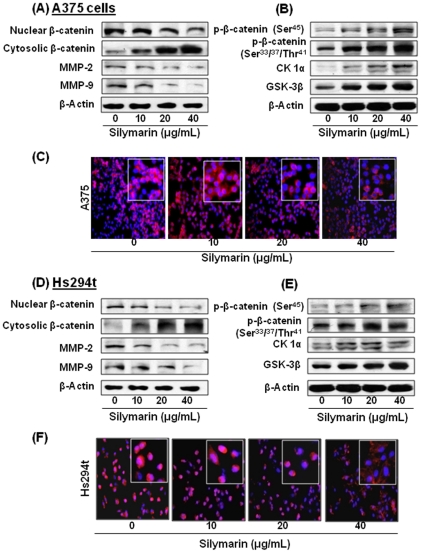
Effect of silymarin on β-catenin and its signaling molecules in melanoma cells.(A) Effect of silymarin on the cytosolic and nuclear accumulation of β-catenin, and MMP-2 and MMP-9, which are downstream targets of β-catenin, in BRAF-mutated A375 cells. (B) Effect of silymarin on phosphorylation of β-catenin at “critical residues” and on the expression levels of regulatory kinases (GSK-3β, CK1α) implicated in determining nuclear/cytoplasmic accumulation of β-catenin. (C) Immunofluorescence staining shows decrease in nuclear accumulation of β-catenin in A375 cells after the treatment of cells with silymarin for 24 h in a dose-dependent manner. Magnified nuclear staining is shown in the cells inside the box. (D) The effect of silymarin on nuclear and cytosolic levels of β-catenin and its target MMPs proteins important for the cell migration in Hs294t cells after the treatment of cells for 24 h. (E) Effect of silymarin on phosphorylation of β-catenin at “critical residues” and on the expression levels of regulatory kinases (GSK-3β, CK1α) in metastasis-specific Hs294t cells. (F) Immunofluorescence staining showing decrease in nuclear accumulation of β-catenin in Hs294t cells in a dose-dependent manner after treatment of cells with silymarin for 24 h. Magnified nuclear staining is shown in cells inside the box.